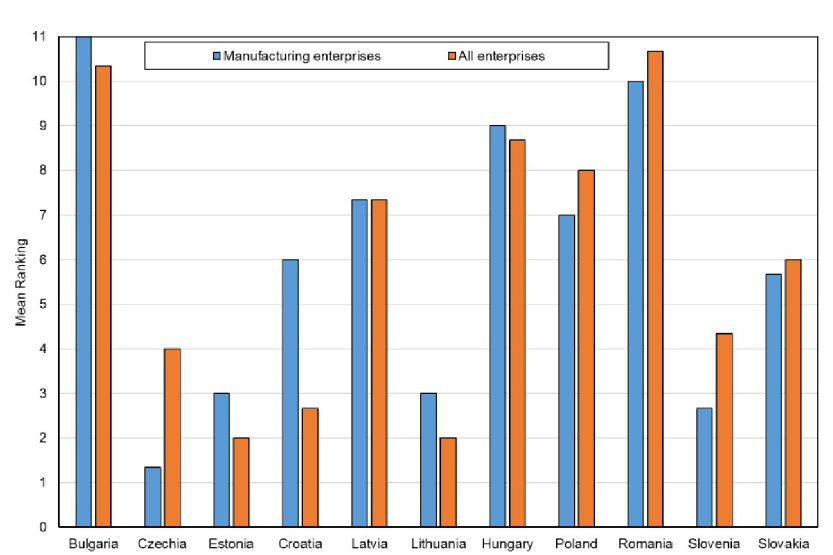
Fig 8. The ranking of the CEE countries in terms of digital maturity among their enterprises by the mean-rank method.